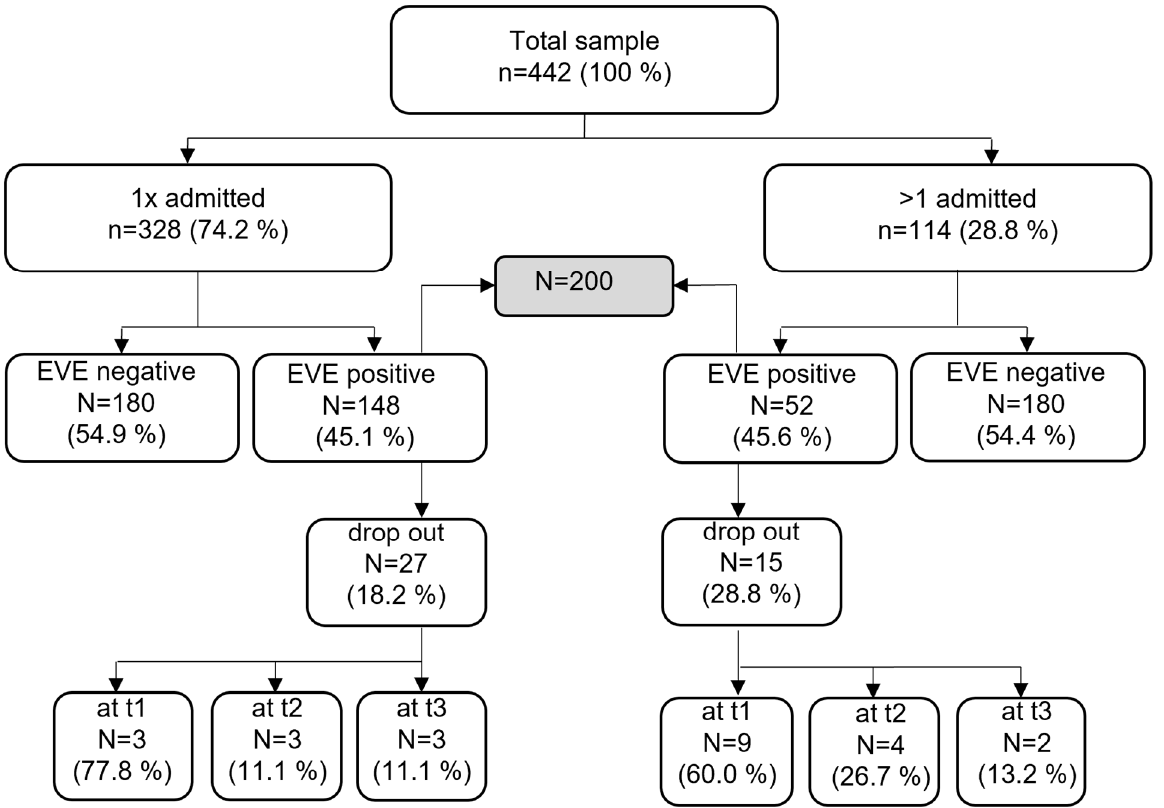
Figure 1. Consort diagram of study sample; EVE acceptance signature.